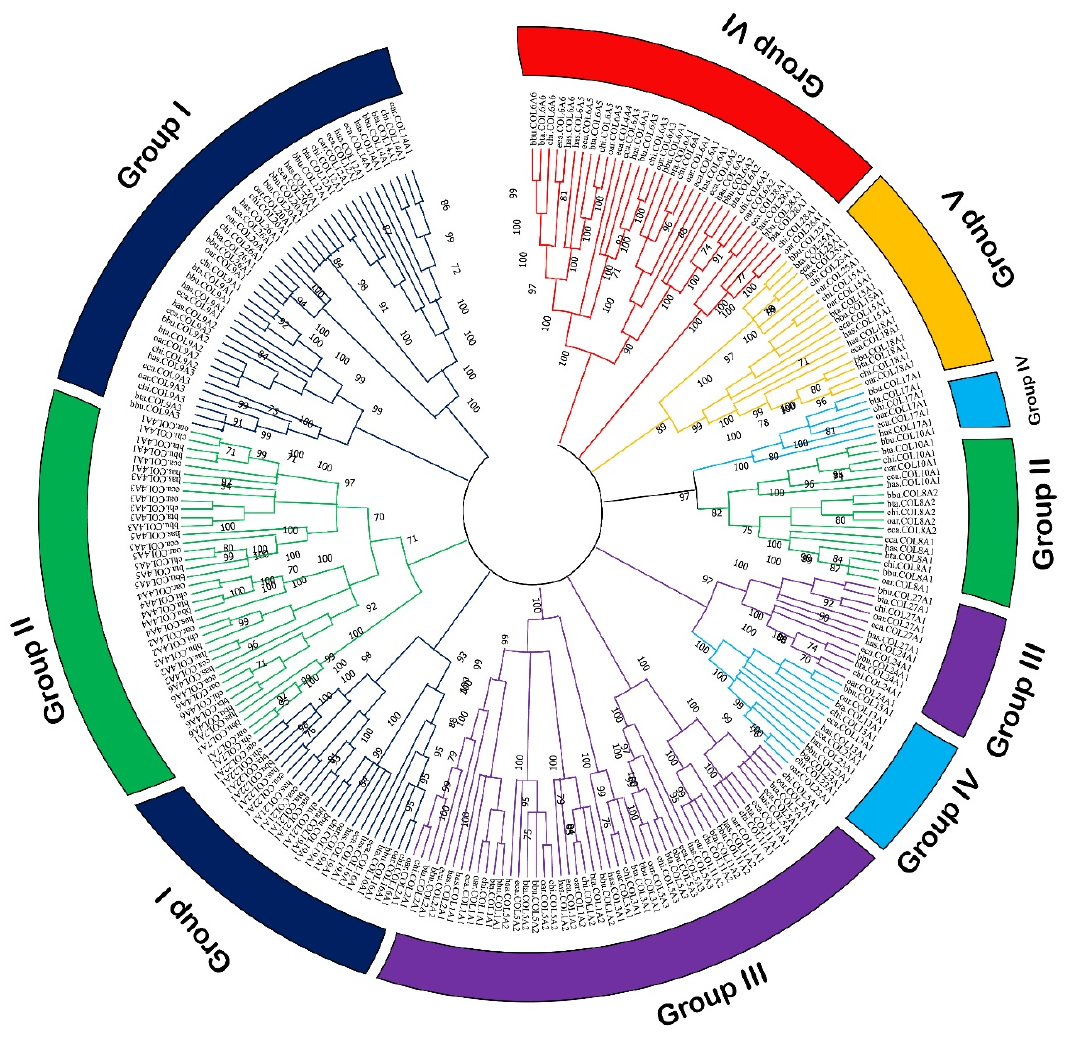
Figure 1. Phylogenetic relationship of collagen proteins in six mammals. Line with different colors indicates different groups. Circle of different color also indicates different groups. Buffalo: bbu; Cattle: bta; Goat: chi; Sheep: oar; Horse: eca; Human: has.